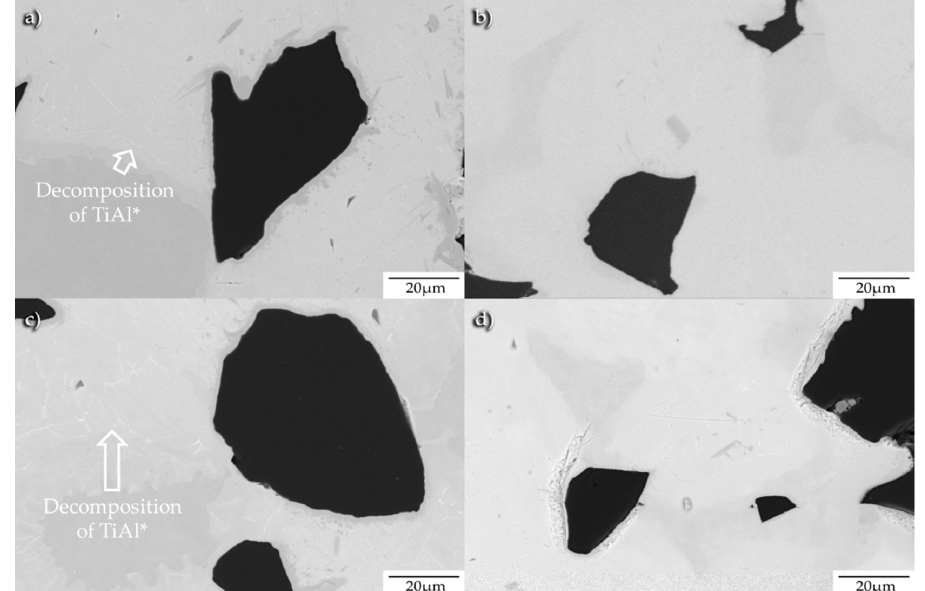
Figure 7. SEM images of the TMCs processed for 5 min, from the starting materials: ( a ) Ti matrix with TiAl* and B 4 C particles at 1100 °C under 40 MPa; ( b ) Ti matrix with TiAl and B 4 C particles at 1100 °C under 40 MPa; ( c ) Ti matrix with Ti-Al and B 4 C particles at 1100 °C under 80 MPa; ( d ) Ti matrix with Ti-Al blend and B 4 C particles at 1100 °C under 80 MPa.